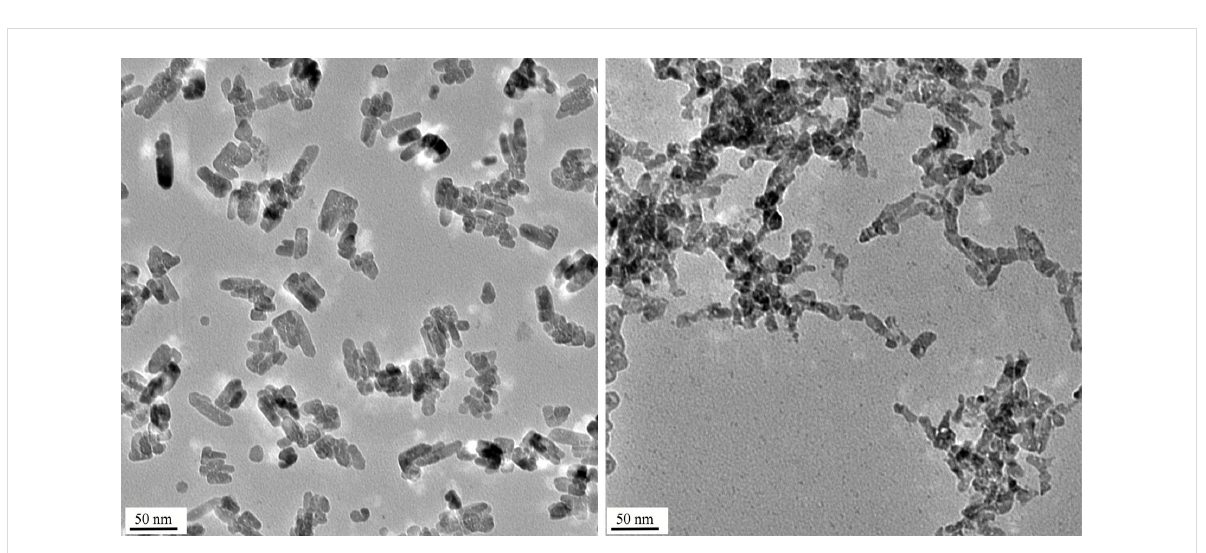
Figure 2: TEM pictures of ZnO-NP 1 (labeled with a perylene dye) as prepared (left) and after one hour of reaction with buffer A (right). The scale bars are 50 nm.